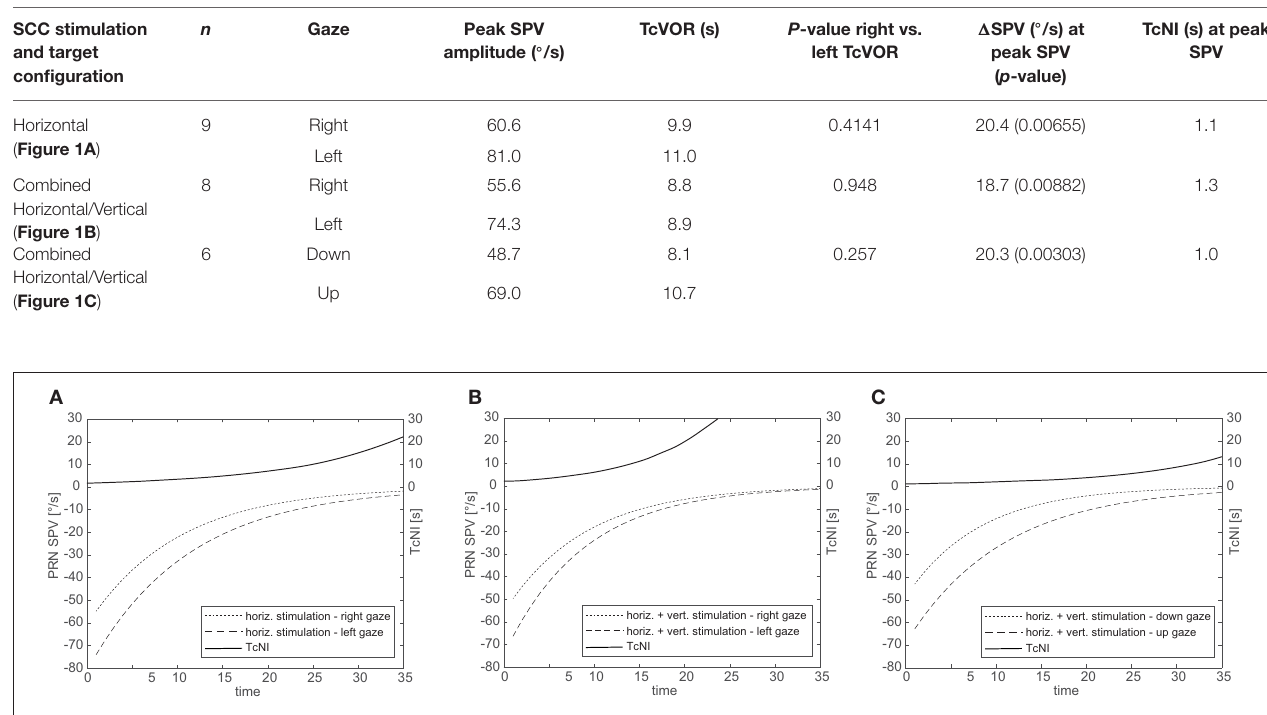
FIGURE 3 | Aggregate results for all subjects for SPV decay over time for right and left gaze (A,B) and up and down gaze (C) . The solid line illustrates the corresponding TcNI. Note that the TcNI begins to return toward normal when SPV drop to the range of 8–16 ◦ /s.